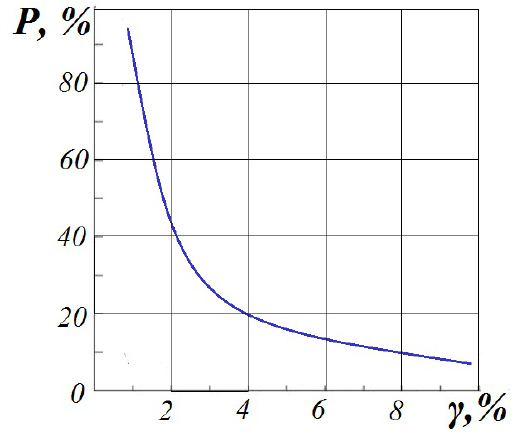
Fig. 2. . The dependency of the fraction of working pulses on the percentage concentration of erosion products in the working